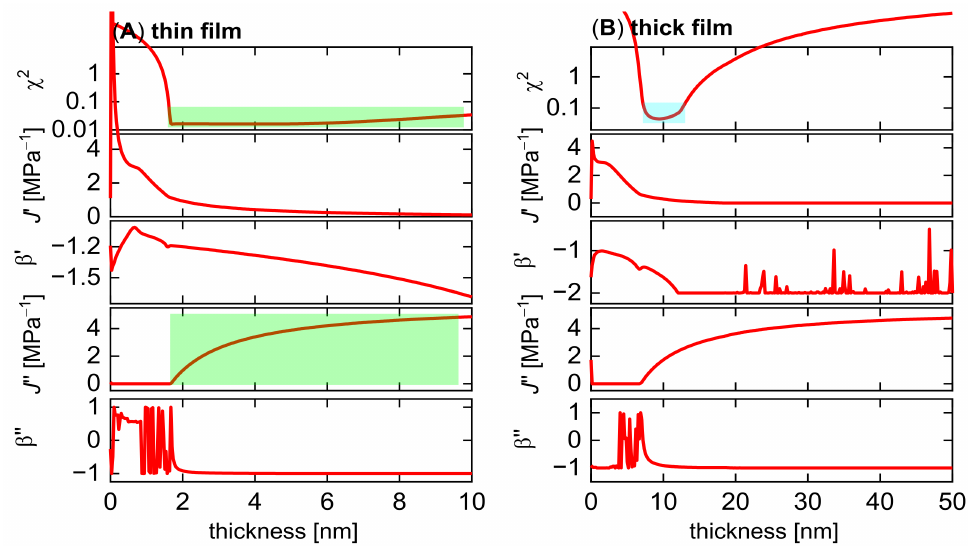
Figure 11. An analysis of the χ 2 landscape for the datasets shown in Figure 7B,C. The software prescribes values for the thickness in a certain range (0 to 10 nm in ( A ) and fits the remaining parameters, which are J f (cid:48) , β (cid:48) , J f ”, and β ”. Given that the thickness is no longer a free parameter, χ 2 is larger than what is obtained with d f as a free parameter. As the top panel in ( A ) shows, χ 2 is very large when d f is smaller than 2 nm, but is only marginally larger than the minimum value when d f is larger than 2 nm. The fit compensates for a large thickness with a large J (cid:48) and finds a good match with the experimental data (green bars on the left-hand side). The algorithm cannot distinguish between films that are either thin and stiff or thick and soft. The valley in the χ 2 landscape is not at all sharp, and a statement on the thickness is difficult. These problems are much alleviated in ( B ) because the fractional errors have decreased in Figure 7C compared to Figure 7B. The valley in the χ 2 landscape is now sharp (top in ( B ), light blue bar). On a qualitative level, the data now allow for a robust statement on the curvatures (Figure 7C). The interpretation can rest on a total of six robust experimental parameters (offsets, slopes, and curvatures in plots of ∆ f / n and ∆Γ / n versus n .) Five model parameters can be inferred from six experimental parameters. The fit problem is now overdetermined (as it should